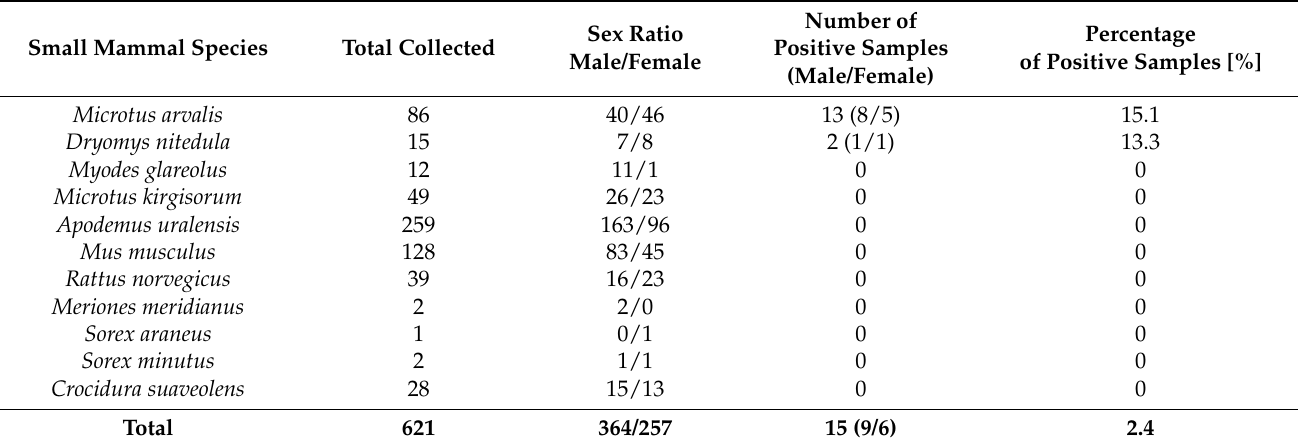
Table 2. Result of the molecular biological screen for orthohantavirus RNA among small mammals captured in the regions of